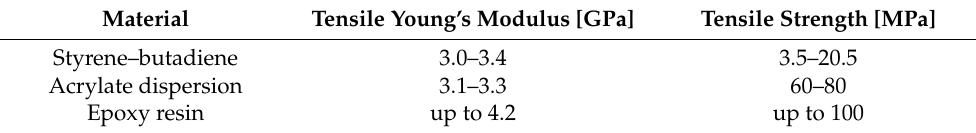
Table 2. Mechanical characteristics of impregnation agents (polymers), adapted from [14]. Material